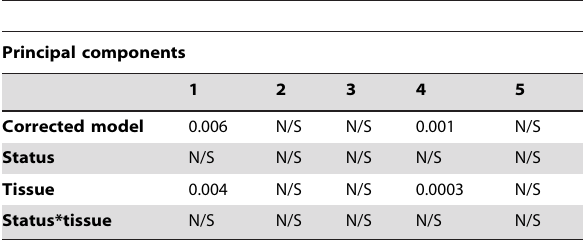
Table 2. T-cell repertoire is different between tissues but not between GF and colonised